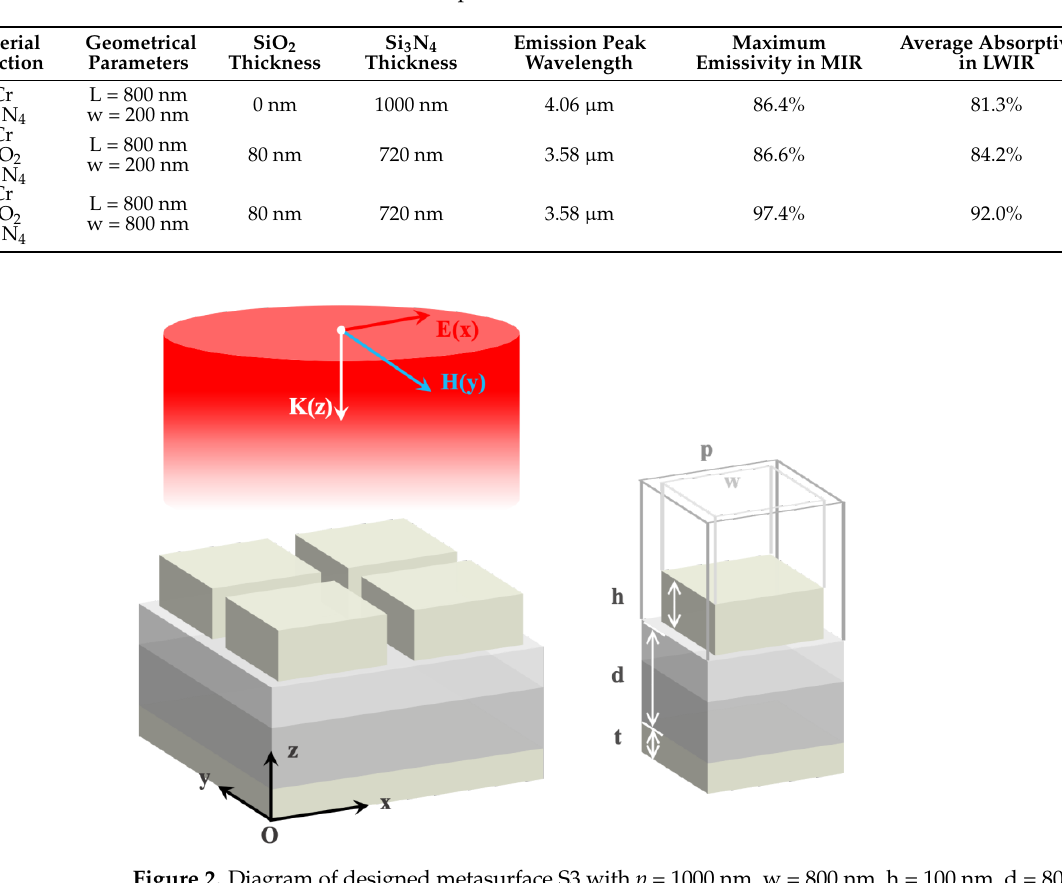
Table 1. Fundamental structural parameters and numerical simulation results of S1, S2, and S3.